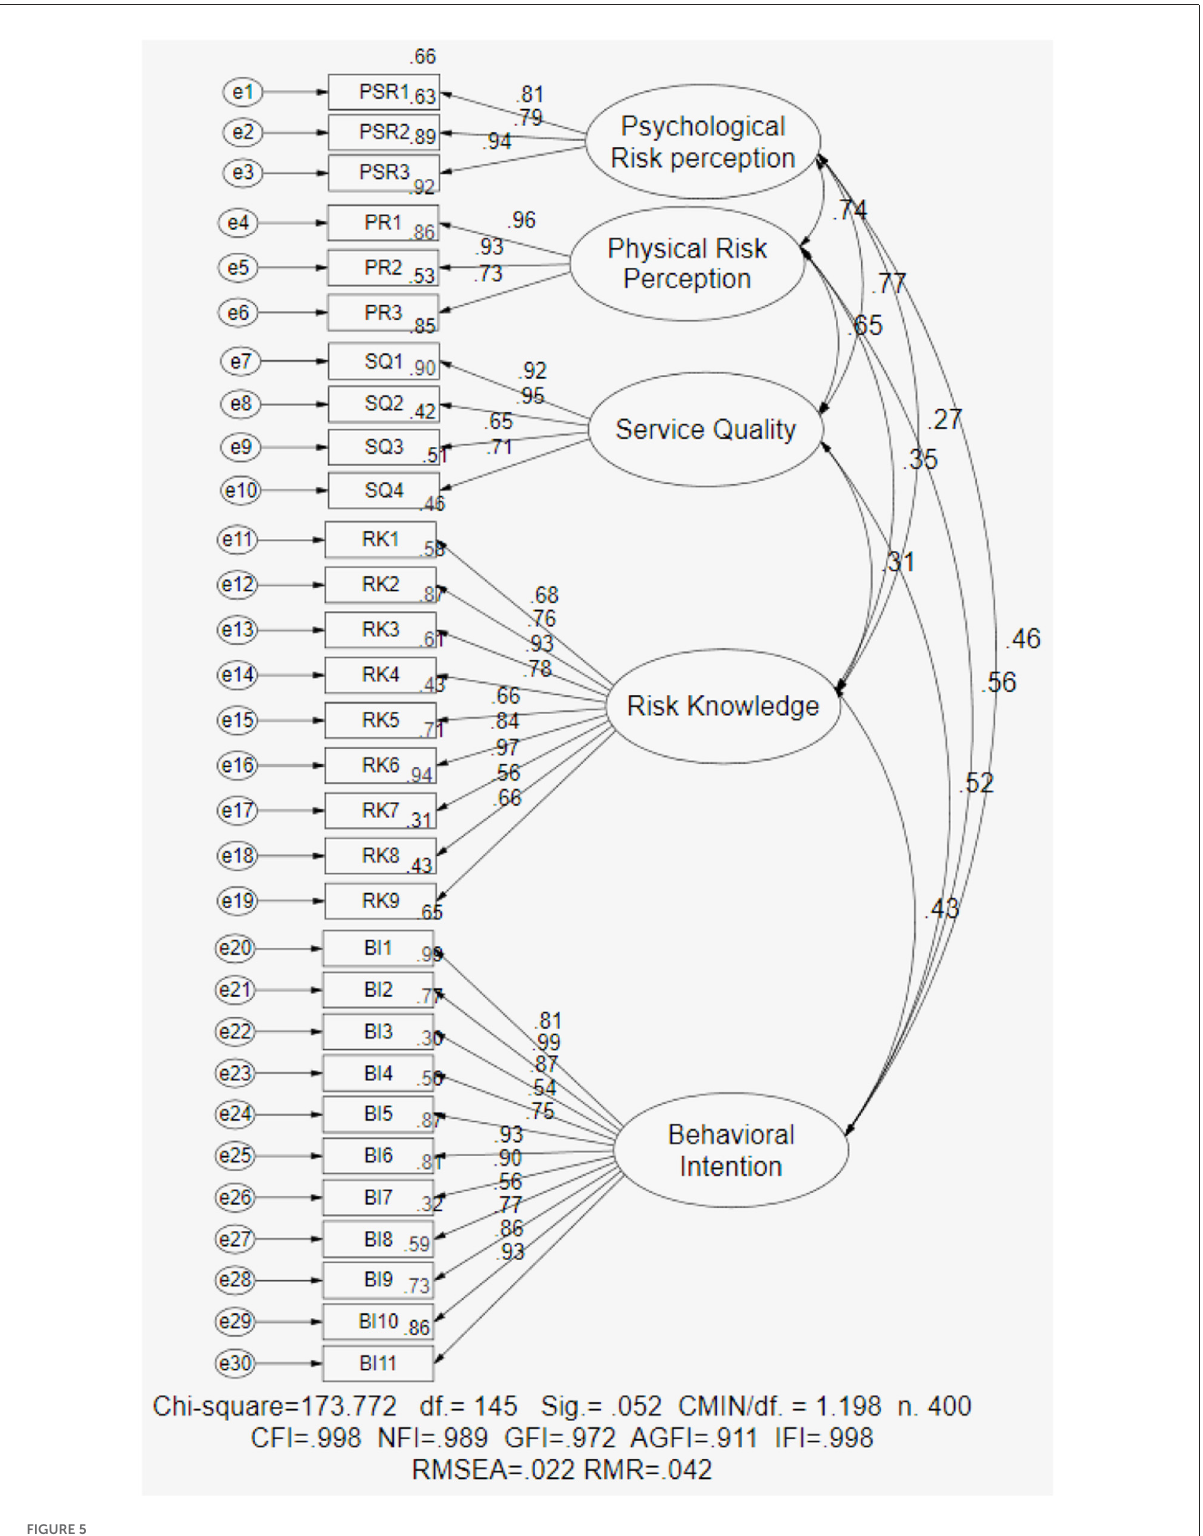
FIGURE5 Confirmatory factor analysis (CFA) of the model of risk knowledge pathways to behavioral intention of air travel risk perception during